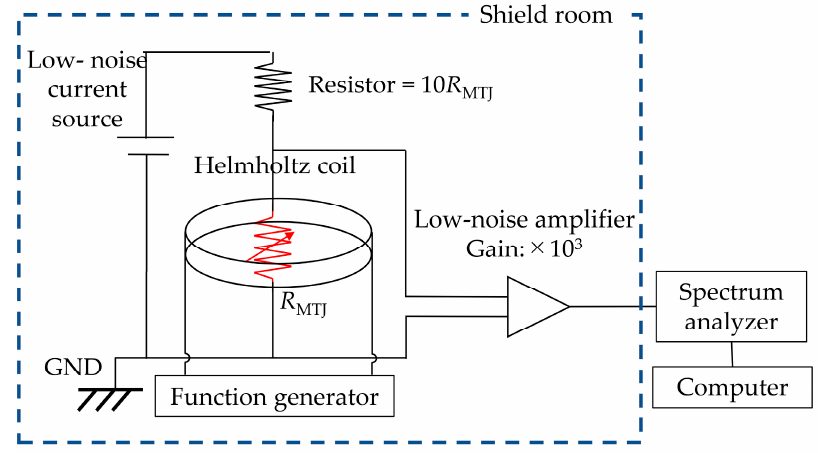
Figure 2. Schematic diagram showing detection of the AC magnetic field using an MTJ sensor.